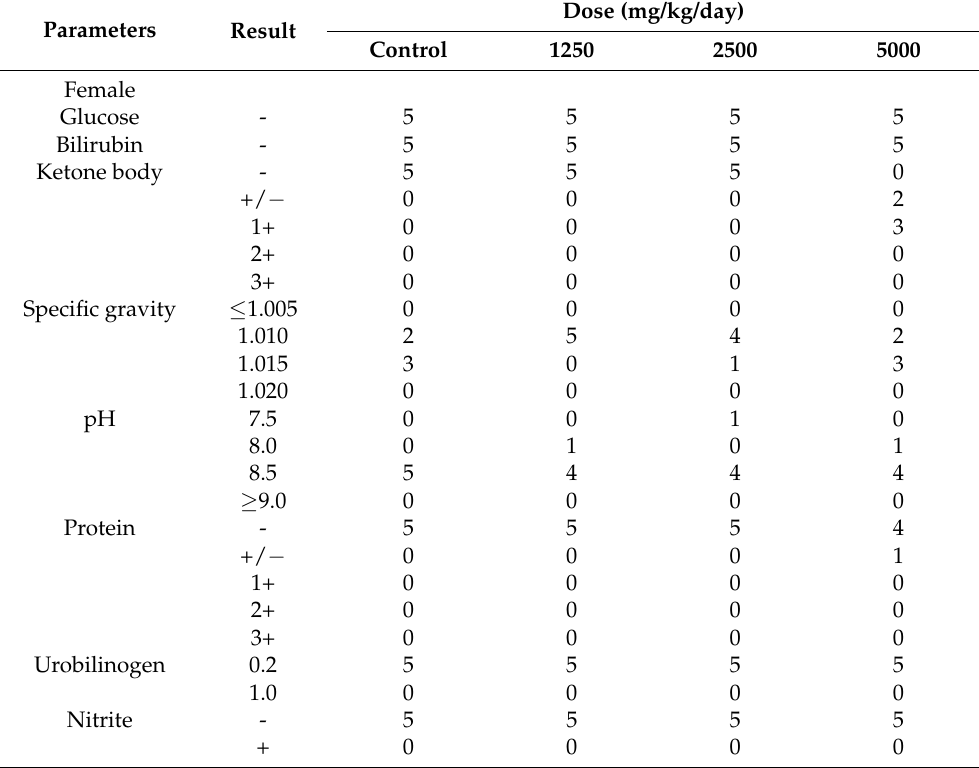
Table 6. Urinalysis in 13 weeks repeated oral dose toxicity of WG extract in female rats.